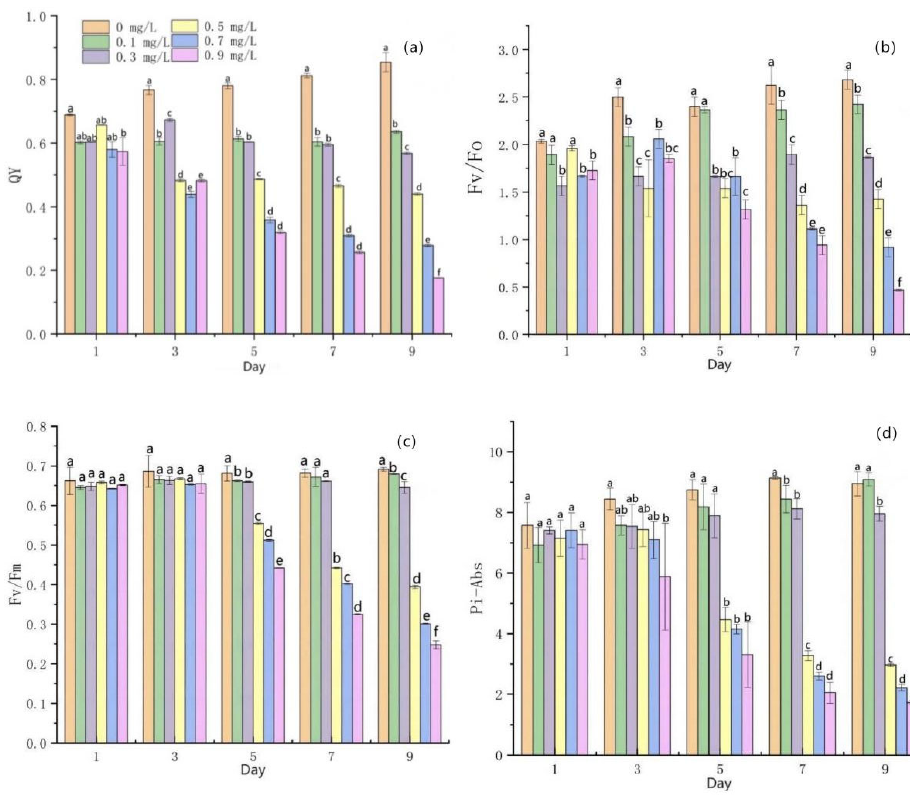
Figure 7. Effects of mercuric chloride concentration on chlorophyll fluorescence parameters of Scenedesmus quadricauda : ( a ) QY (quantum yield); ( b ) Fv/Fo (potential activity of photosystem II); ( c ) Fv/Fm (maximum quantum yield of photosystem II photochemistry; ( d ) Pi-ABS (maximum quan- tum yield of photosystem II photochemistry) (N = 3, the calculated value is the standard deviation).